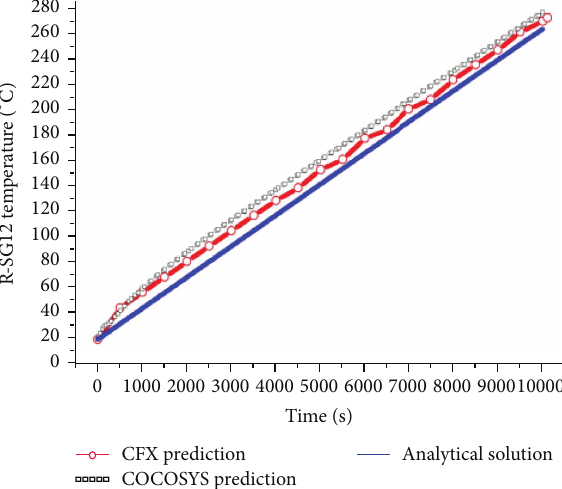
Figure 3: Comparison of zone temperature at transient state.